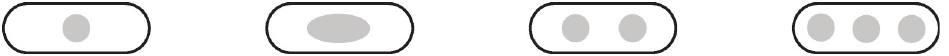
Fig 4. Canal morphologies in cross section. Left to right: Round and ovoid canal forms. Gray is canal shape, black is external form of the tooth root.